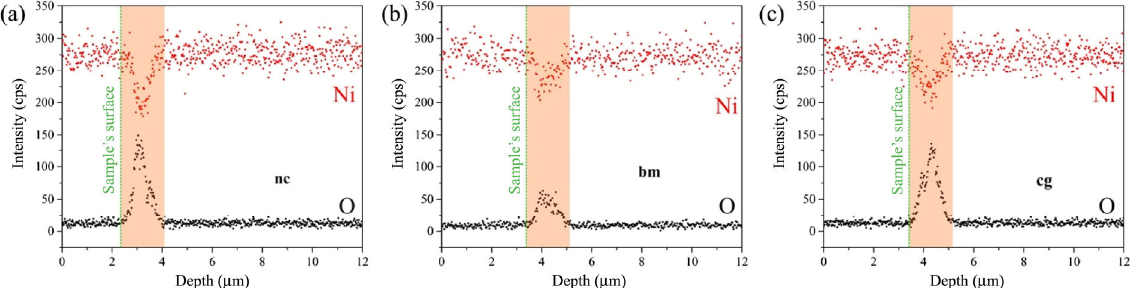
Fig. 5 Chemical concentration profile (EDS line scan) along the cross-section of (a) the coarse-grained, (b) the nanocrystalline, and (c) bimodal sample after 5,000 sliding cycles measured with a normal force of 5